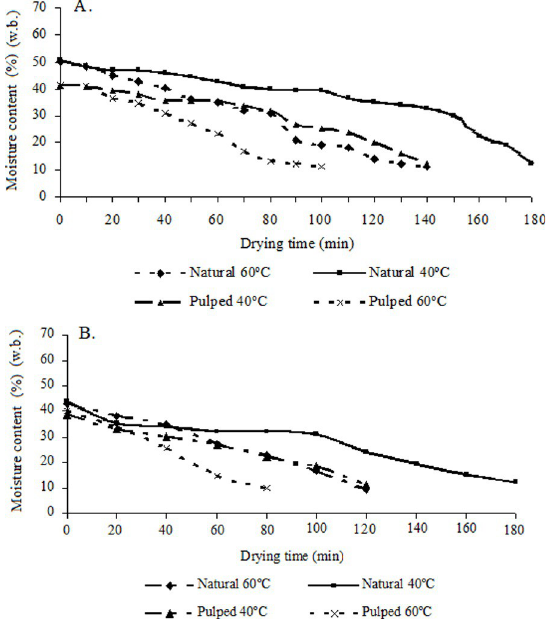
Fig 6. Drying curves at temperatures of 40˚C and 60˚C for natural and pulped coffees. First drying (A), second drying (B).